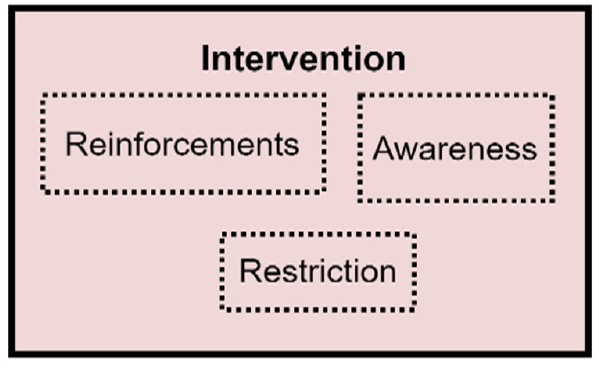
Figure 7. The expanded Intervention component.